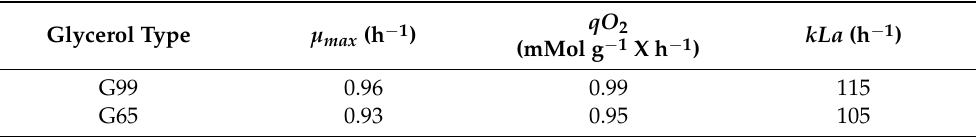
Table 5. Kinetic parameters of rTBL-1 production using P. pastoris in a fed-batch system at 1000 rpm, pH 4.5, and 1 vvm using G99 or G65